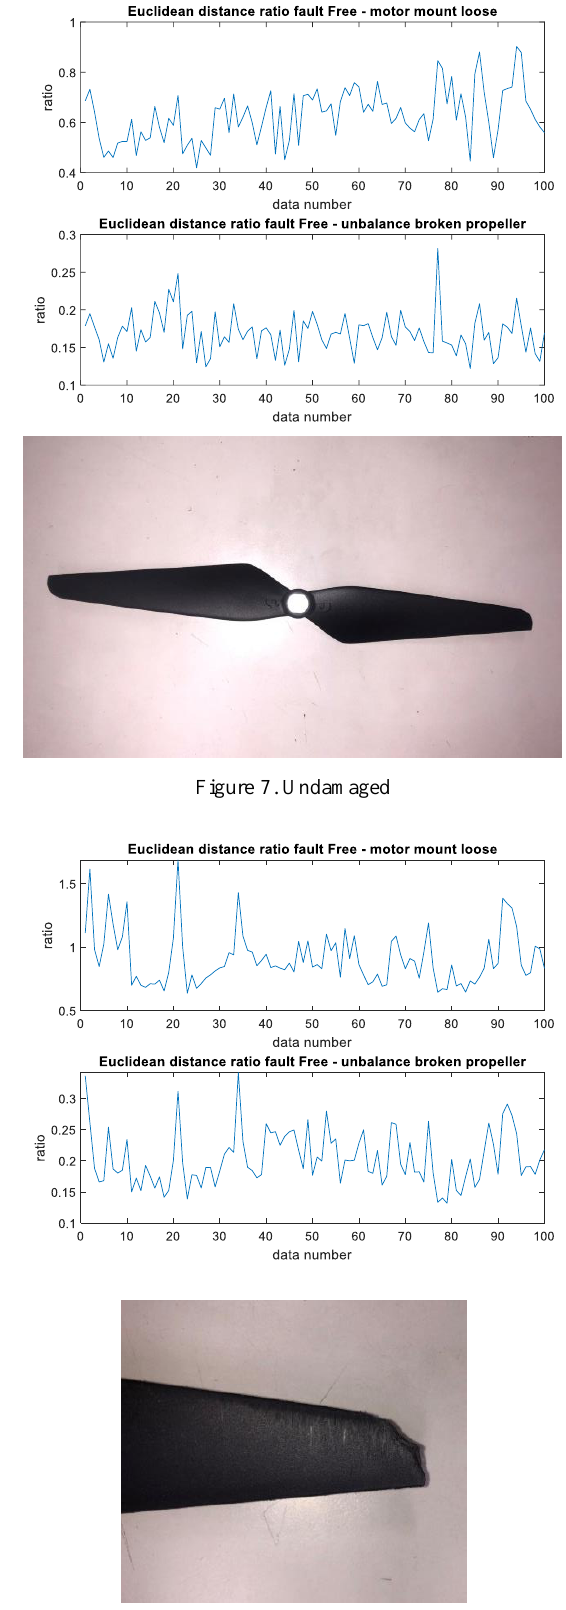
Figure 8. Little damage on the edge of